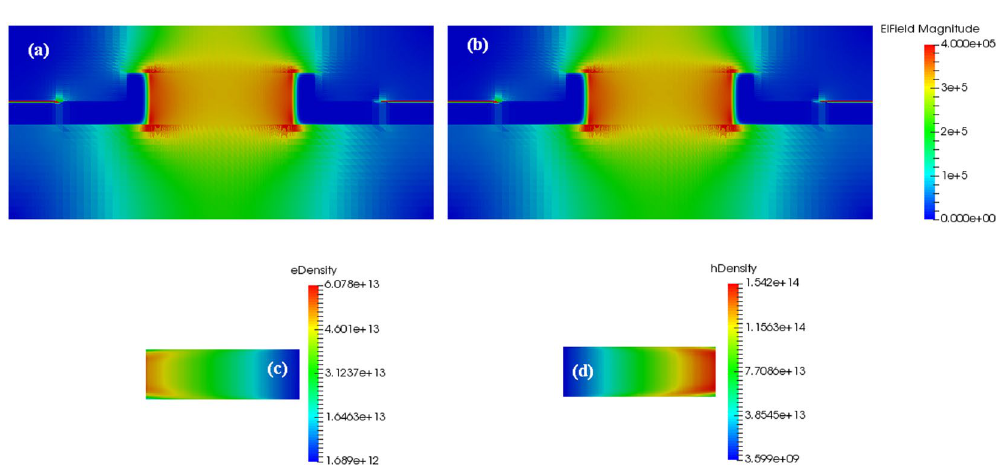
Figure 3. ( a ) DC electric field distribution, for G op = 0 cm − 3 s − 1 , and V bias = − 20 V. ( b ) DC electric field distribution, for G op = 4 × 10 26 cm − 3 s − 1 , and V bias = − 20 V. ( c ) Zoom of the electron density distribution in